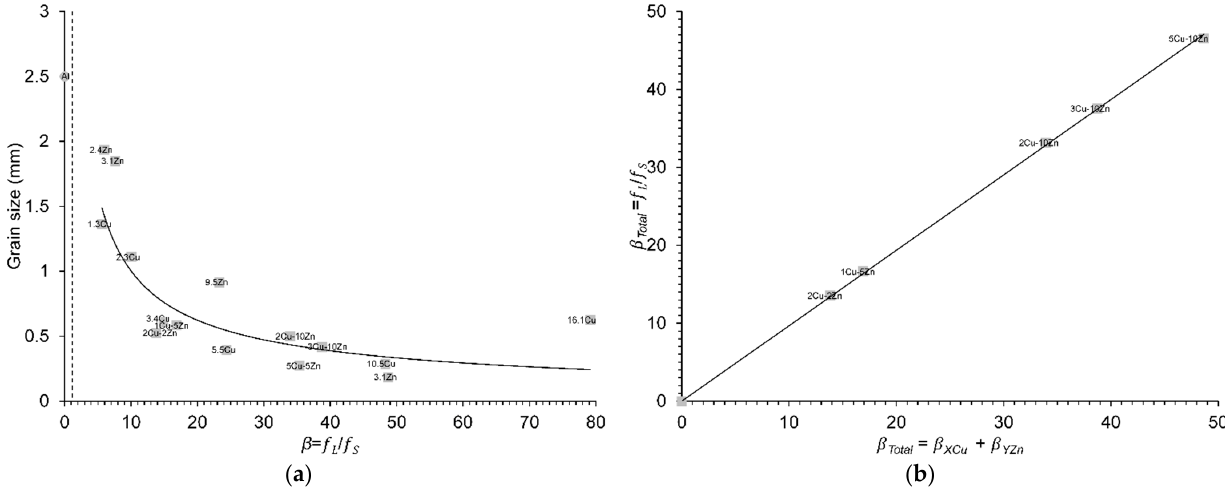
Figure 5. ( a ) Variation in grain size values from Xu et al., data from [18] with the true β values at Δ T = 0.5 K for different solute additions in binary and ternary Al alloys. The dashed line corresponds to the true β of 1.14 (CET criterion) data from [16]. The Al circle point represents the initial columnar grain size of CP Al for reference; ( b ) comparison between true β values calculated using Equation (3) for the ternary Al–XCu–YZn alloy systems of Ref. [18] and those calculated using Equation (4) for the linear addition of each binary system, β Al-XCu and β Al-YZn . The reader is referred to the web version of this article for alloy compositions given in data-point labels.